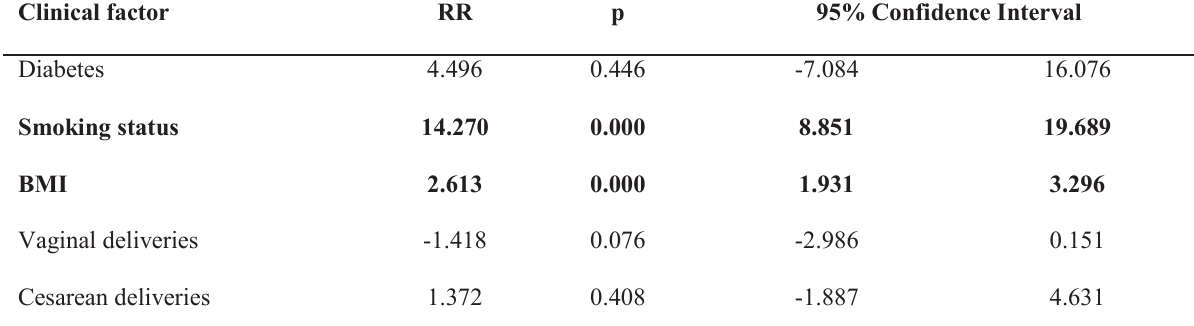
Table 2 - Clinical factors related to CIPP on multivariate